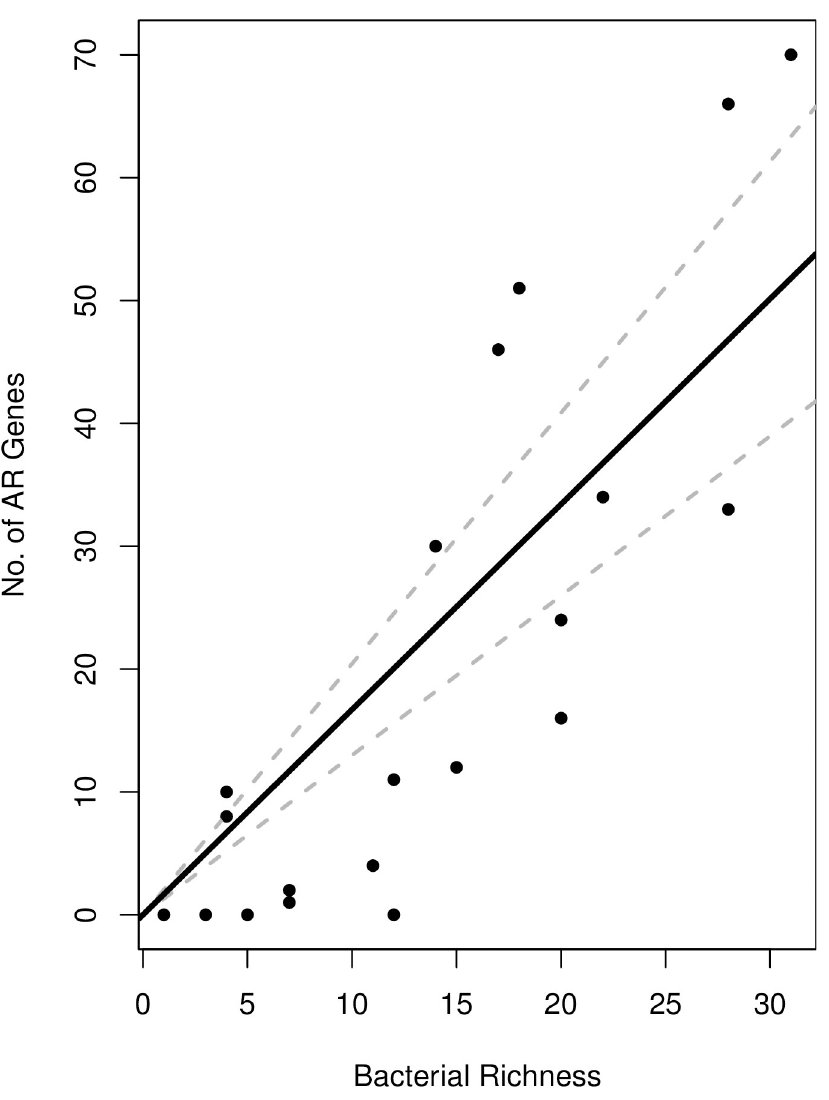
Fig 2. Linear relationship of the metagenomic ARGs as a function of bacterial richness. The dotted slope estimate based on the theoretical model suggests a linear relationship between bacterial richness and the number of resistance genes in the community with a zero intercept and a slope equal to pN = 7.66 e − 04 � 2122 = 1.63. The solid slope estimate from a linear regression on the empirical data estimates the slope is 1.67. mean = 20.9, median = 11.5 genes, and IQR = 31.5) (Table 1, S1 and S3 Tables). The 95 unique genes created products that either interact with 12 antibiotic drug classes [fluoroquinolone, aminoglycoside, tetracycline, beta-lactam, macrolide, phenol, elfamycin, pseudomonic acid, aminocoumarin, streptothricin, streptogramin, and (poly)peptide], or are part of multidrug efflux pumps. In total, multidrug efflux pump related genes were detected 149 times, tetracy- cline detected 106 times, macrolide 57, beta-lactam 25, fluoroquinolone 18, phenol 16, elfamycin 15, aminoglycoside 9, (poly)peptide 9, pseudomonic acid 7, aminocoumarin 3, streptothricin 2, and streptogramin 2 (Fig 3). Although in small amounts, we detected genes playing a role in resistance to methicillin and polymixins, including mec R1 (2 detected), arn A (2 detected), and pmr A (3 detected), respectively.